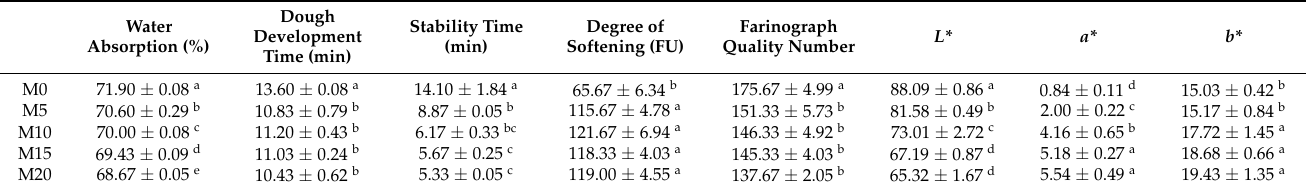
Figure 2. Farinograph curves of high-gluten wheat flour formulated with 0% (M0), 5% (M5), 10% (M10), 15% (M15), and 20% (M20) mealworm powder. BU: Brabender unit. Table 3. Farinograph properties and color of high-gluten wheat flour with 0% (M0), 5% (M5), 10% (M10), 15% (M15), and 20% (M20) mealworm powder substitution